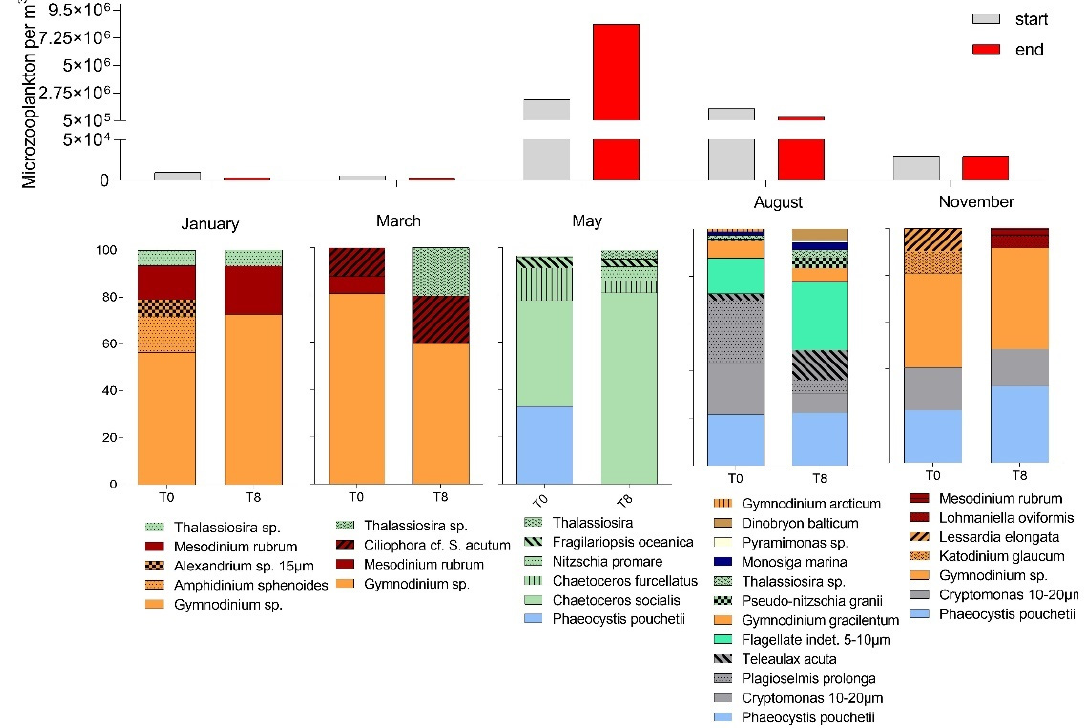
Figure A4. Microscopic counts of Lugol-stained protists at the start and end of the experiments for the <90-µm size fraction.